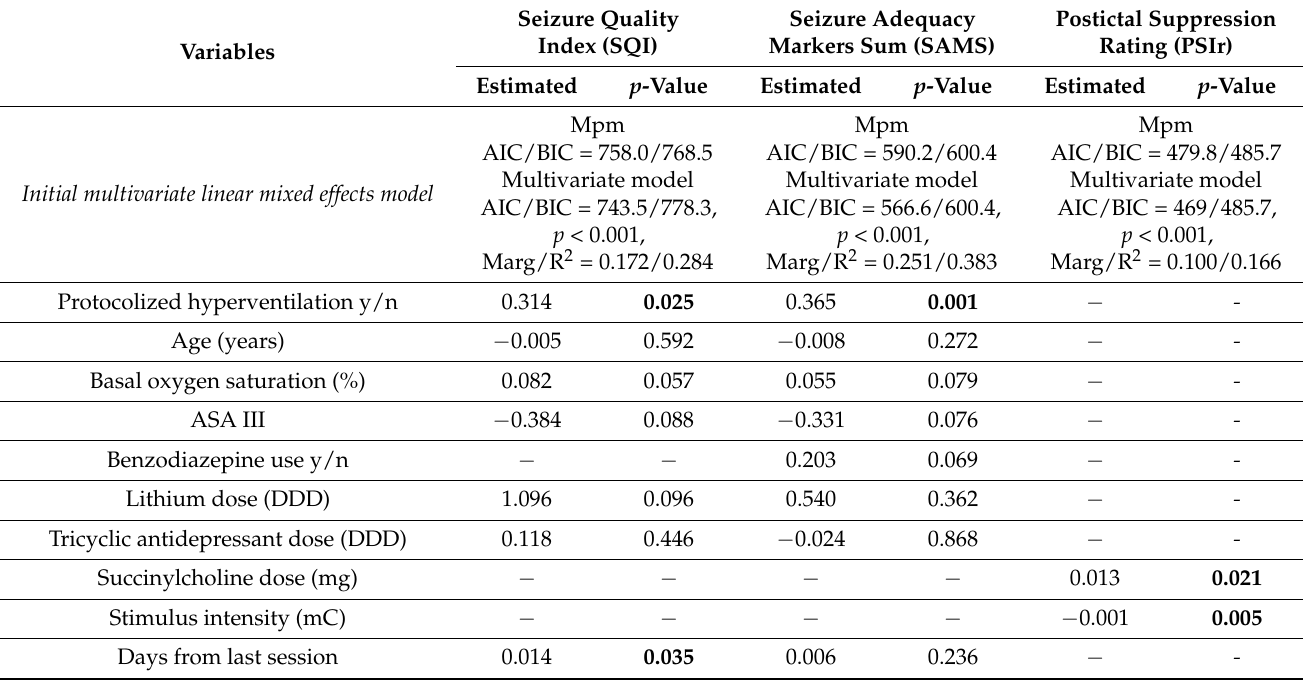
Table 4. Results of multivariate linear mixed effects models of seizure quality associations with clinical and ECT variables.